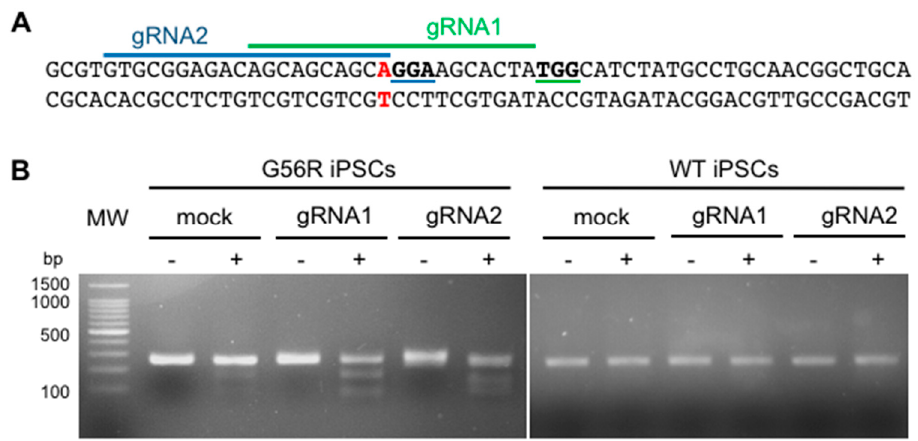
Figure 2. Design and efficiency testing of gRNAs. ( A ) Sequence of exon 2 of NR2E3 in the DNA of the NR2E3 -adRP patient showing the position of the c.166G>A mutational site in red. The position of gRNA1 is indicated by a green line and the corresponding NGG PAM sequence is in bold and underlined in green. The position of gRNA2 is indicated by a blue line and the corresponding NGA PAM sequence is indicated in bold and underlined in blue. ( B ) Gel electrophoresis of the T7E1 assay in G56R and WT iPSCs that were mock-transfected or transfected with gRNA1 or gRNA2. The minus sign indicates the absence, and the plus sign indicates the presence, of T7E1. Molecular weight (MW) marker, 100 bp ladder.